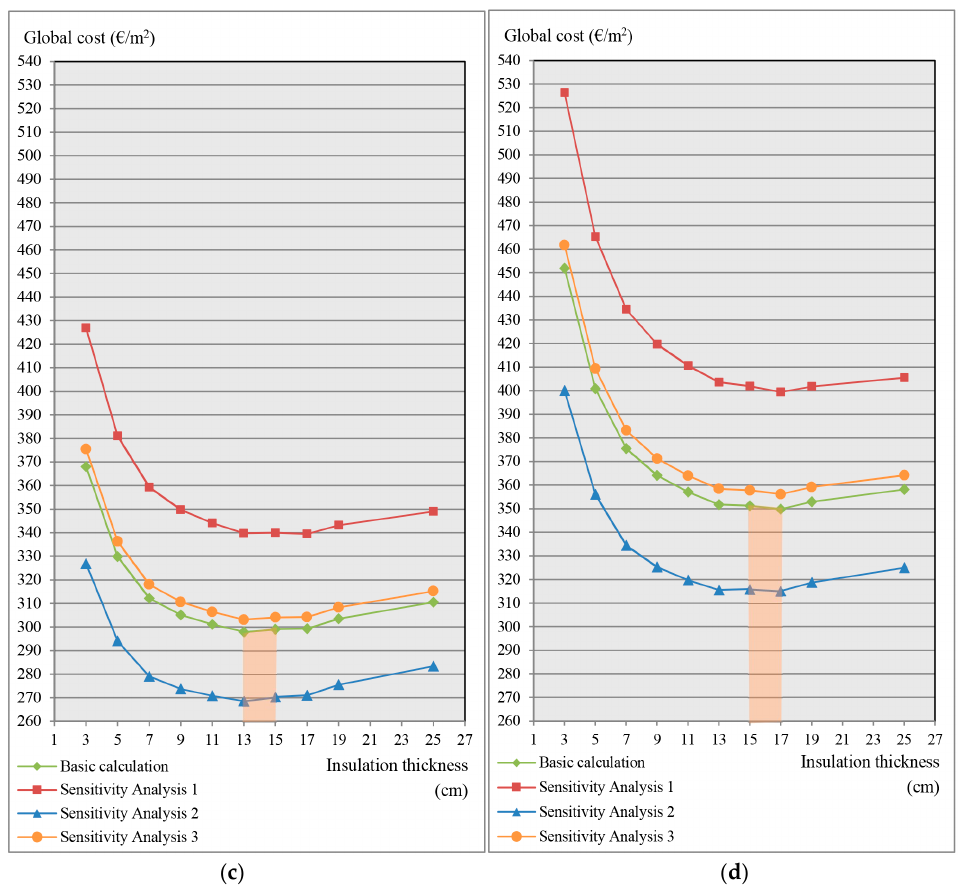
Figure A6. Results of the macroeconomic calculation presented graphically for ( a ) Heraklion (climate zone A); ( b ) Athens (climate zone B); ( c ) Thessaloniki (climate zone C) and ( d ) Kastoria (climate zone D).